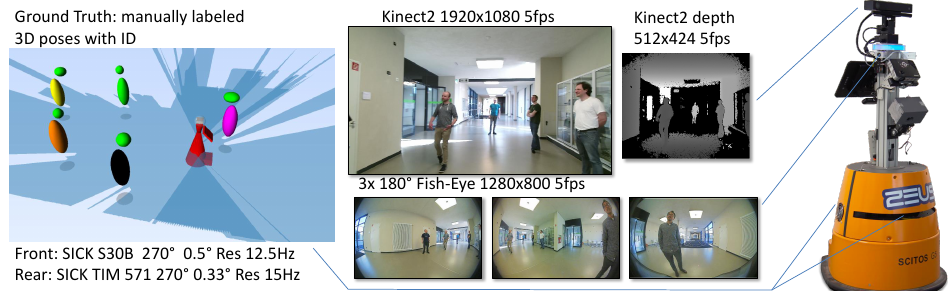
Figure 5. Dataset used for evaluation and the robot which has been used for recording (published in [22]) The sensor equipment for recording the dataset was similar that of the robot used in the real training application (see Figure 1) except the mounting point of the Kinect2 RGB-D camera.